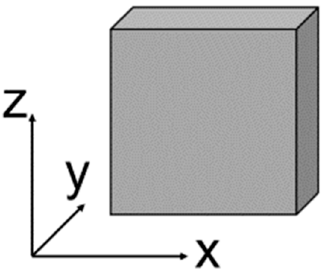
Figure 12. μ‐ CT specimen with convention of the associated axis system.